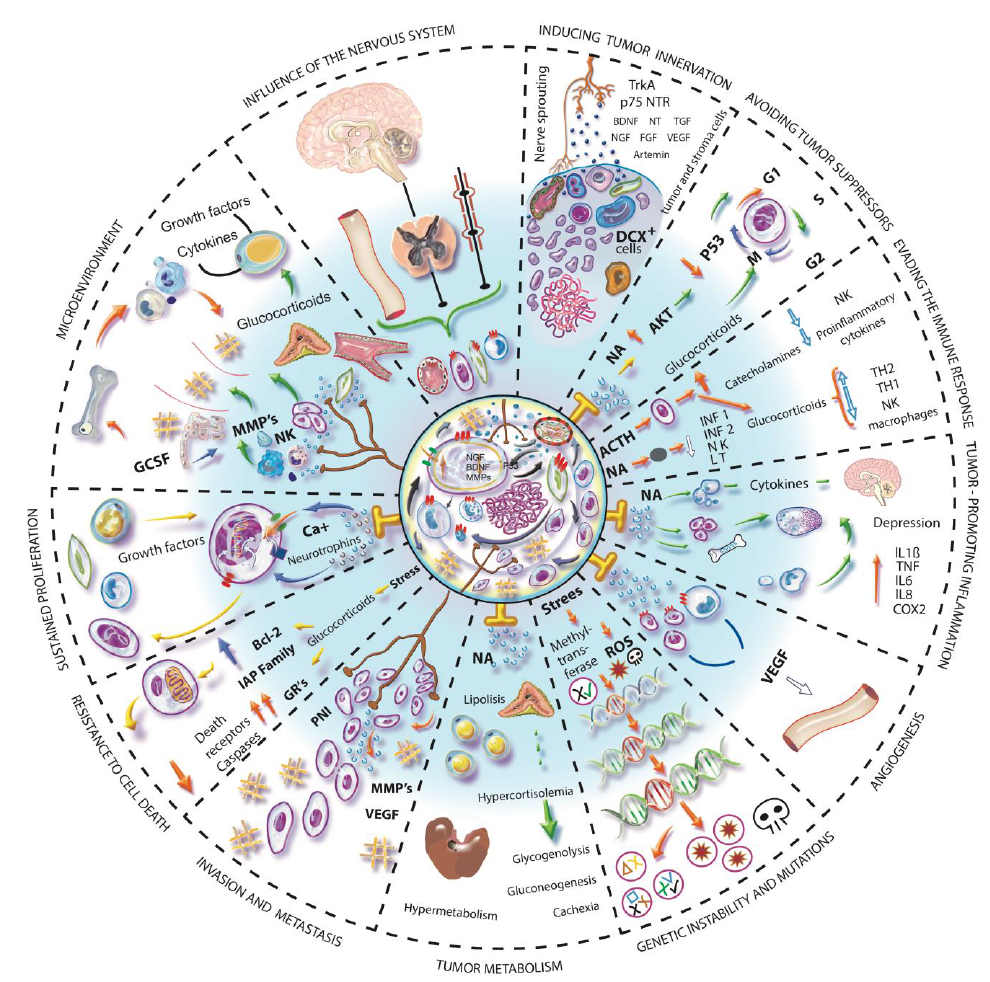
Figure 2. Influence of the nervous system in hallmarks of cancer. The nervous system by its pleiotropic effect can influence different mechanisms involved in the hallmarks of cancer. Communication occurs via hematogenous or neural pathways and stimulates different types of cells inside and outside the tumor. INDUCING TUMOR INNERVATION. Tumor and stromal cells release various neurotrophic factors that induce peripheral nerves to innervate the tumor. Furthermore, DCX + cells can differentiate and generate tumor innervations. AVOIDING TUMOR SUPPRESSORS. The adrenergic stimulus causes an increase in cAMP and activation of AKT, which results in the ubiquitination of p53 and its subsequent degradation, which will cause the accumulation of DNA damage and the maintenance of cell division. EVADING THE IMMUNE RESPONSE. Both the HPA axis and the SNA regulate the response to stress, the consequent release of glucocorticoids and catecholamines have an immunosuppressive effect, suppress the production of proinflammatory cytokines and improve the production of anti-inflammatory cytokines. TUMOR-PROMOTING INFLAMMATION. The mobilization of monocytes towards the blood circulation depends on the local adrenergic activity of the bone marrow, in addition, CSF-1 increases its expression by adrenergic activity in macrophages and favors its recruitment in the tumor. Proinflamma- tory cytokines can activate the HPA axis. Cytokines released by chronic stress promote depression-like behavior by disrupting the synthesis and signal transduction of neurotransmitters. ANGIOGENESIS. Adrenergic stimulation and chronic stress favor the expression of proangiogenic factors and some sympathetic nerve fibers can release NPY. GENETIC INSTABILITY AND MUTATION. Stress-related hormones can cause DNA damage and promote cell transformation through the production of